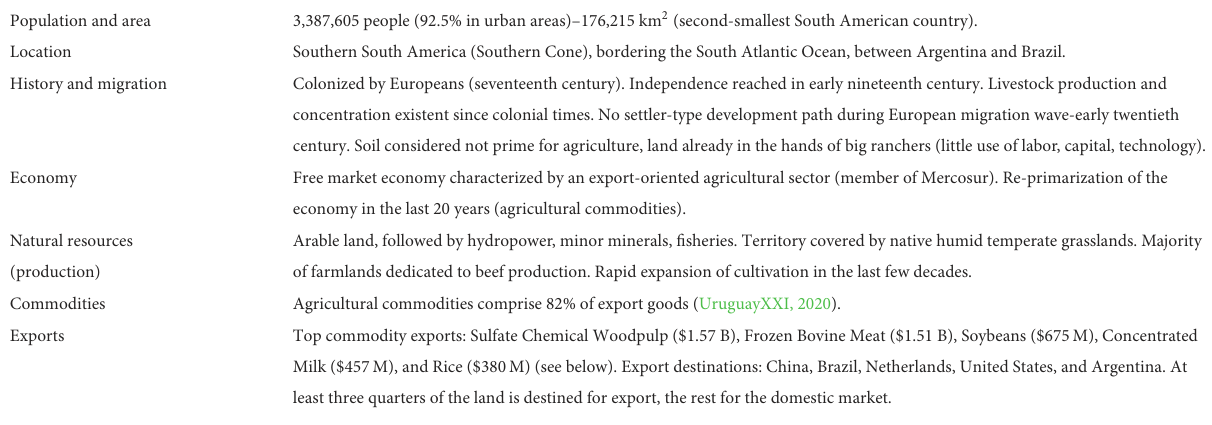
TABLE 1 Main features of Uruguay’s past and present in relation to food systems/agriculture (a), including details on main commodity chains (b). (A) Uruguay’s characterization—main features Population and area